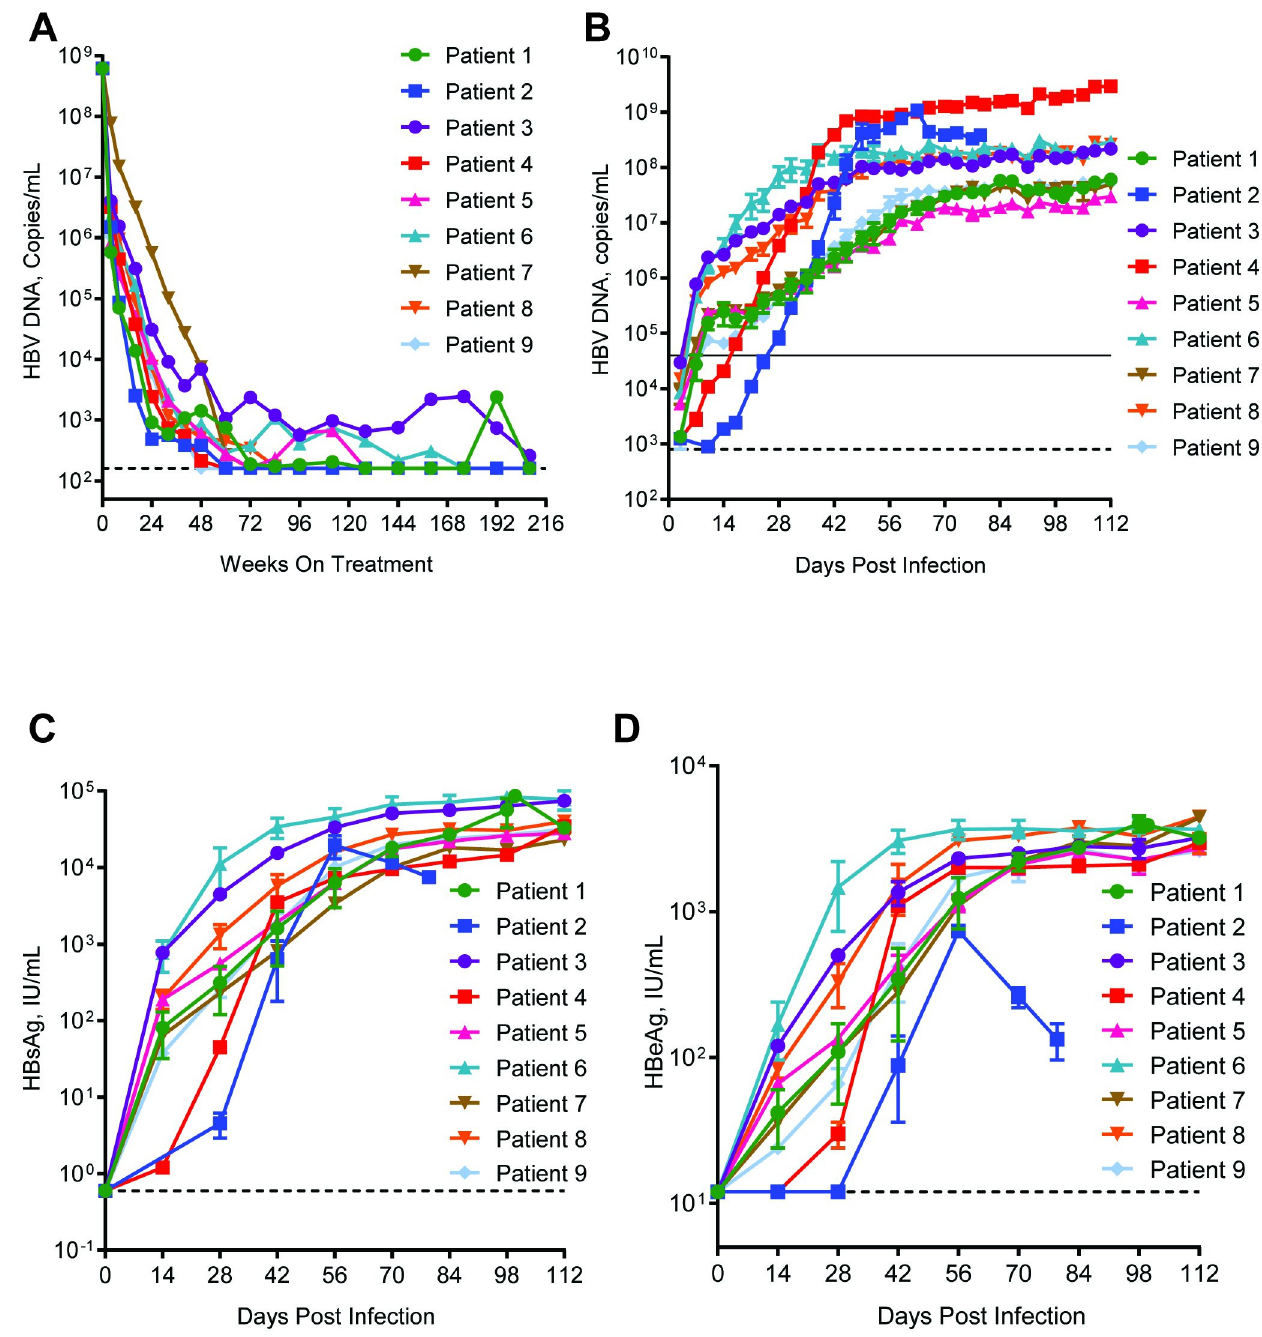
Fig 1. Viral kinetics of 9 patients on NA treatment and when inoculated in the uPA-SCID mouse model. a, Viral kinetics of the patients selected for this study following administration of TDF or TDF/FTC. HBV DNA was measured by Roche TaqMan COBAS at the indicated timepoints and reported as IU/ mL and converted to copies/mL (5.6 conversion factor). Each line represents an individual patient. The dashed line represents the lower LLOQ of the assay, 162 copies/mL. b, Mice (n = 2 per isolate) were inoculated with 0.1 mL of baseline serum samples from patients chronically infected with HBV genotype B (open symbols) or C (closed symbols). HBV DNA was measured by qRT-PCR and reported as copies/mL. The dashed line represents the LLOQ (4 x 10 4 copies/mL) and the solid line represents the LLOD (8 x 10 2 copies/mL). c, HBsAg was measured by CLEIA (LUMIPULSE HBsAg-HQ) and reported as IU/ mL. The dashed line represents the LLOQ (0.6 IU/mL). d, HBeAg was measured by CLEIA (LUMIPULSE HBeAg) and reported as IU/mL. The dashed line represents the LLOQ (12 IU/mL).